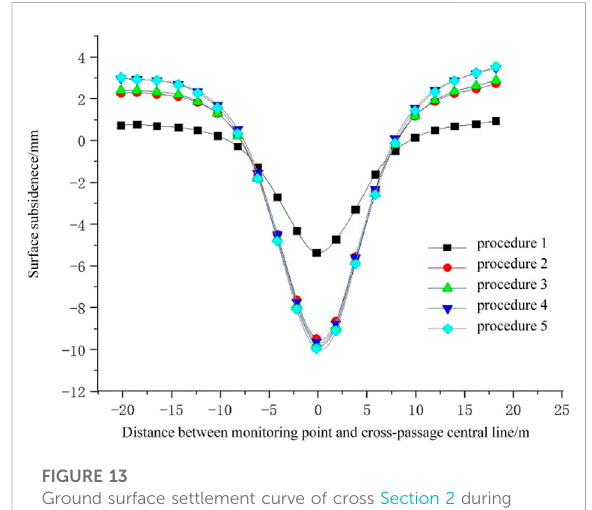
FIGURE 14 Settlement curve of monitoring points.